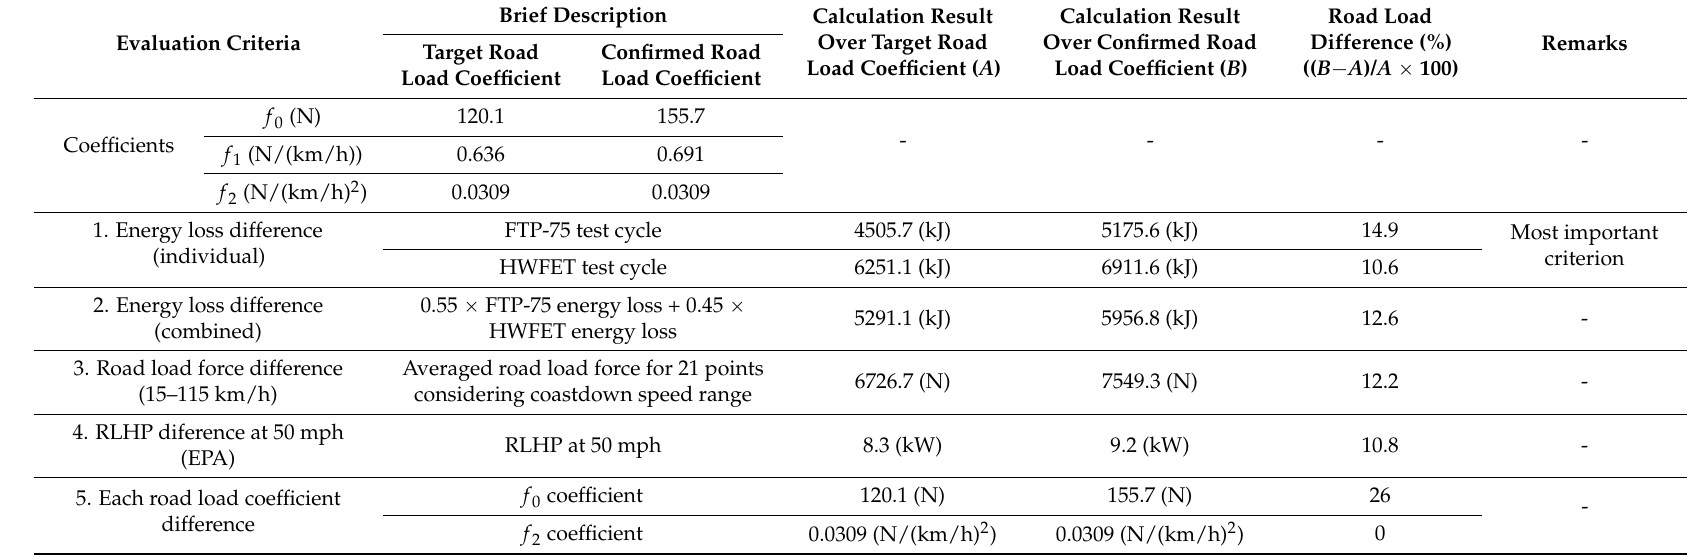
Table 2. Calculation example for the evaluation criteria of road load tolerance. FTP-75: federal test procedure 75; and HWFET: highway fuel economy